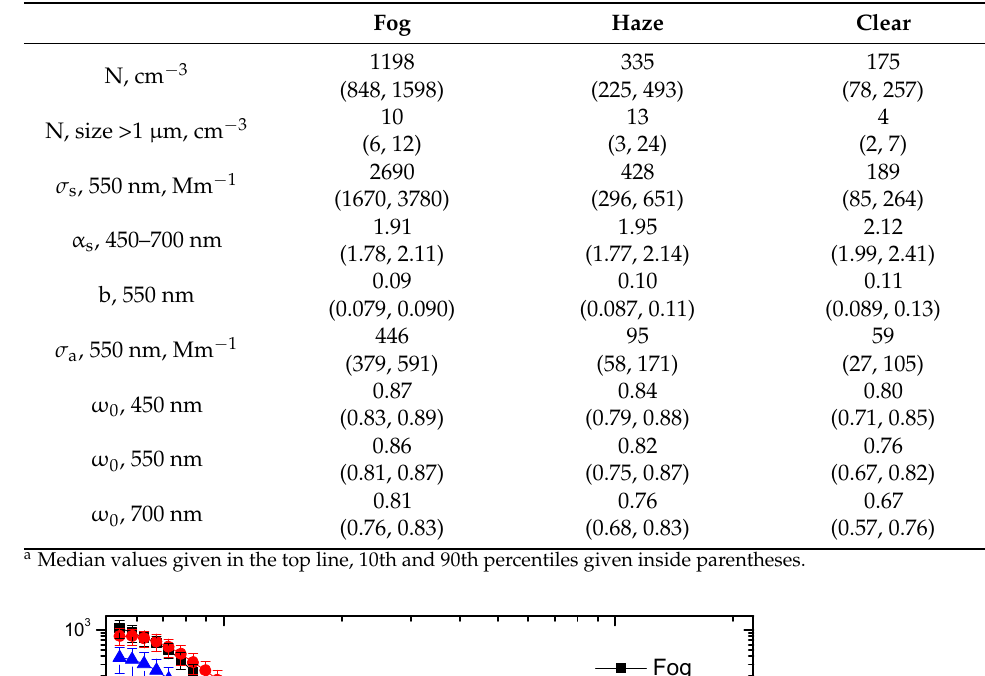
Table 3. Aerosol properties during fog, haze and clear periods a .